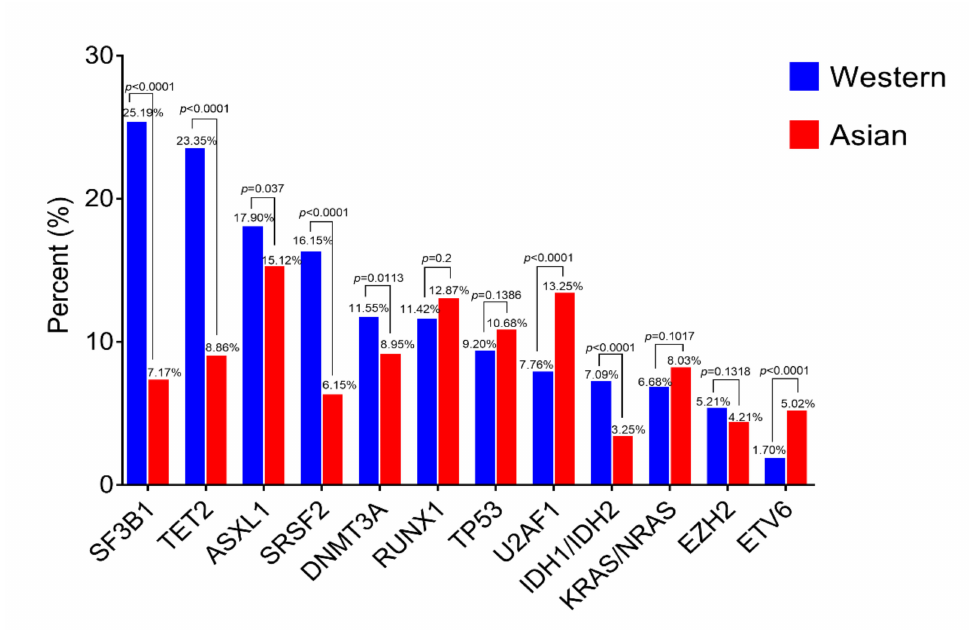
Figure 7. Gene mutation topographies in Western and Asian countries. Frequency of the most common gene mutations in Western and Asian countries. The data were analyzed upon 11 publications [30,62,63,67–74]. Raw data and statistical analysis are presented in Supplemental Table